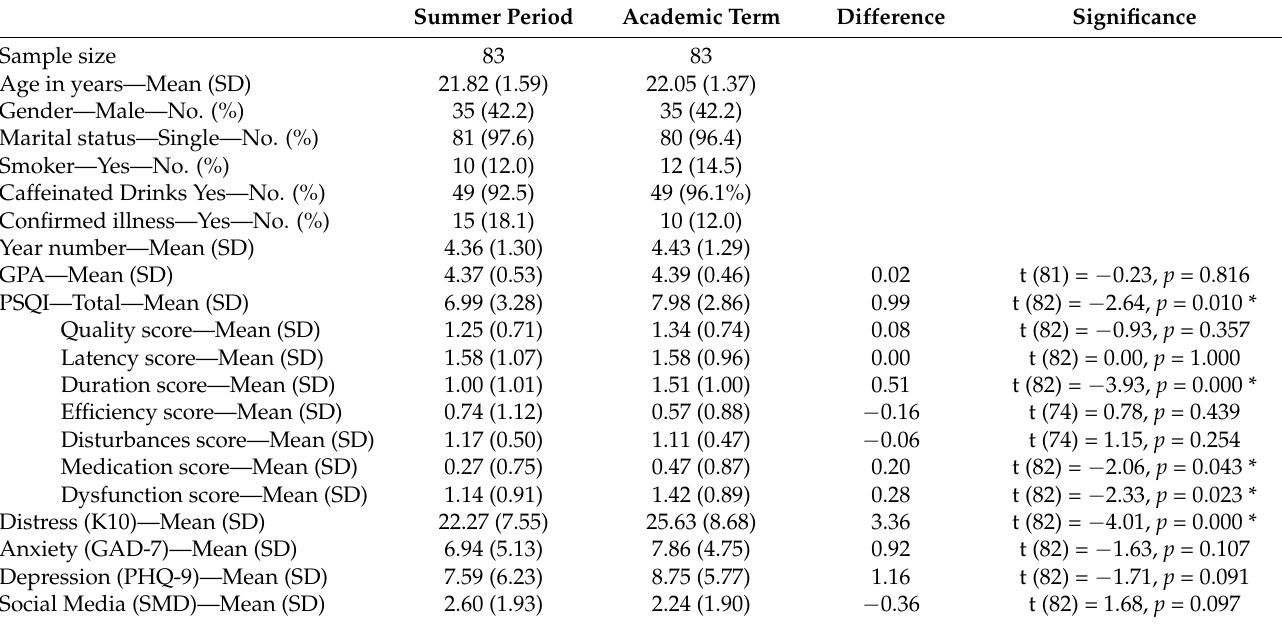
Table 1. Participant demographics and characteristics at each time point. * signifies p < 0.05.